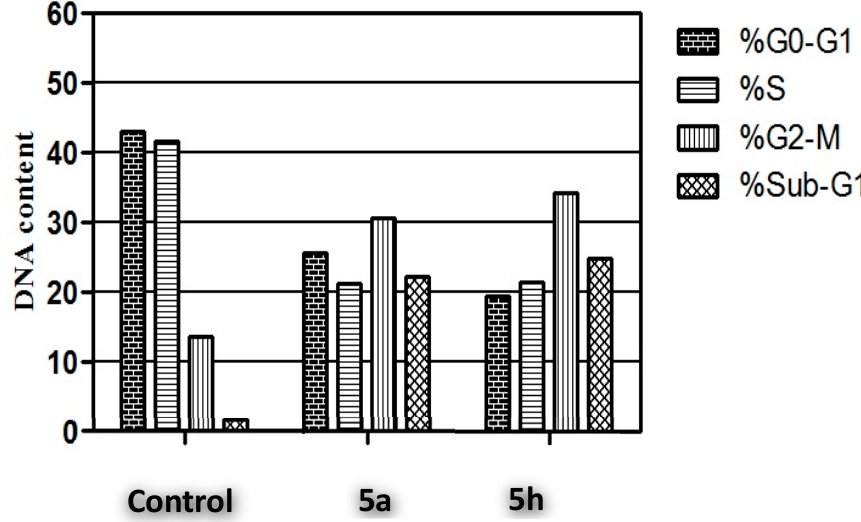
Figure 3. E ff ect of diamide-based benzenesulfonamides 5a and 5h on the phases of cell cycle of UO-31 cells.